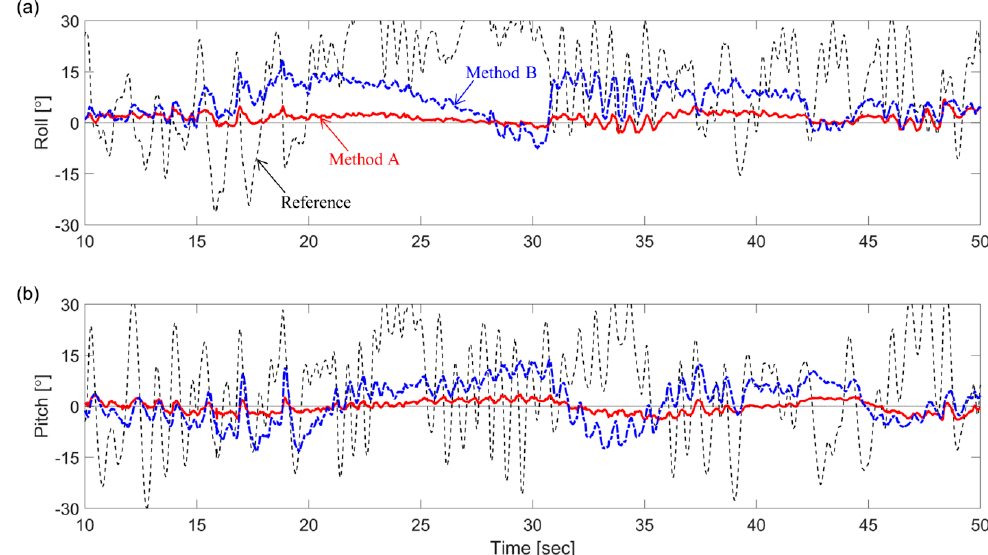
Figure 4. Results of Test 2: ( a ) roll and ( b ) pitch estimation errors from method A and method B during 10–50 s.